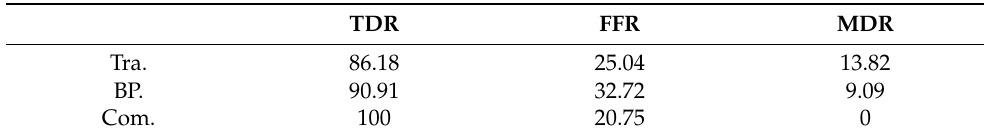
Table 4. Precision of TDR, FFR and MDR of traditional, BP-NN and combined rainfall early warning models (%).